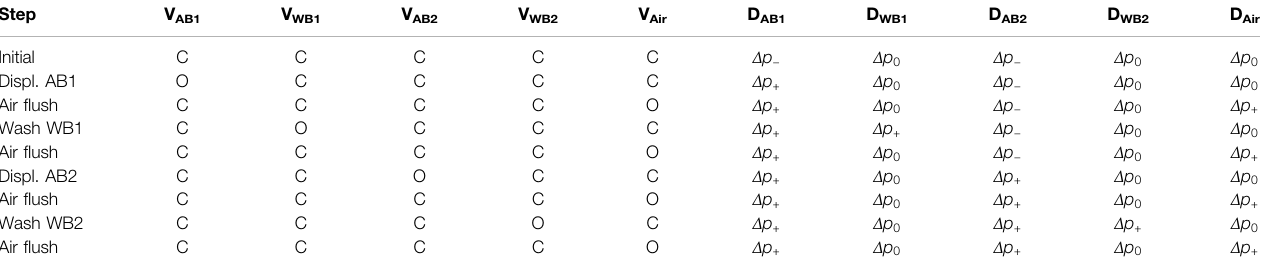
TABLE 3 | Table summarizing the sequence of assay steps and the corresponding conditions of internal valves (V) and external directional control valves (D) (c: closed, o: opened, valve abbreviations according to Figure 2 ). Entries without alteration to the preceding step were grayed out to increase readability.